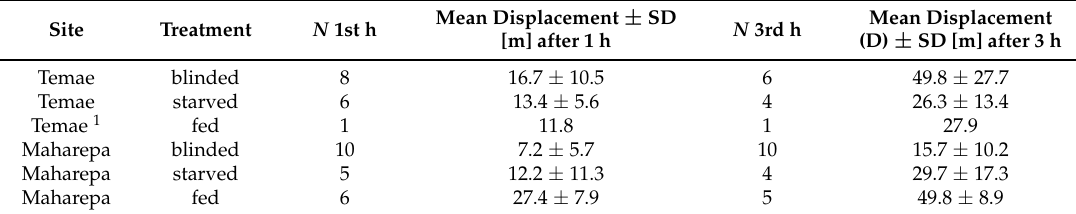
Table 3. Mean distance covered after one and three hours of A. cf. solaris